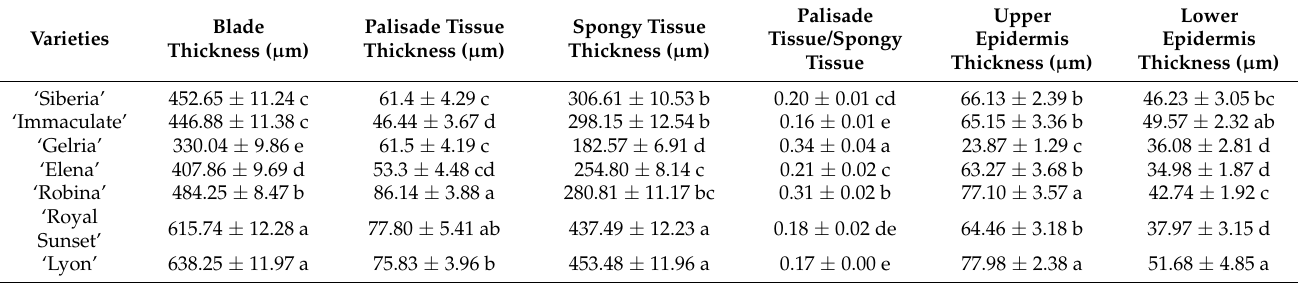
Figure 3. Anatomical structure of leaves of seven lily varieties. UE: upper epidermis; LE: lower epidermis; PA: palisade tissue; SP: spongy tissue. Table 3. Anatomical structure parameters of leaves of seven lily